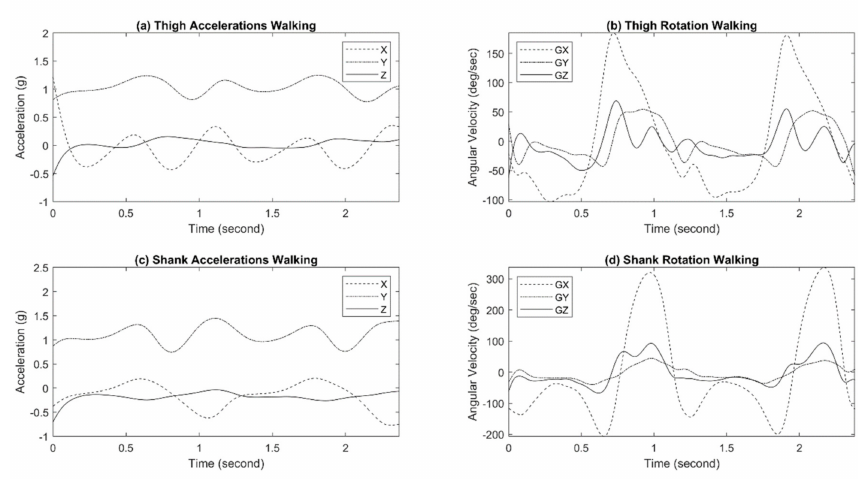
Figure 12. Exo-skeleton inertia measurement unit (IMU) responses during walking.